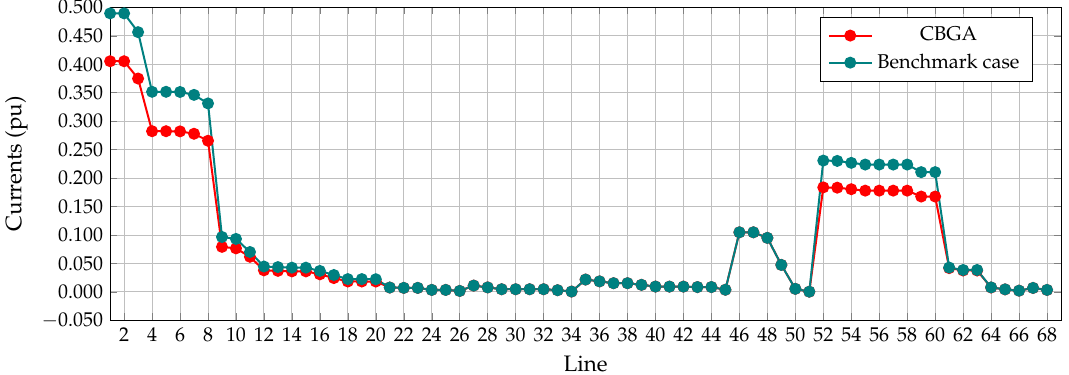
Figure 18. Current magnitude at each line of the 69-node test feeder.